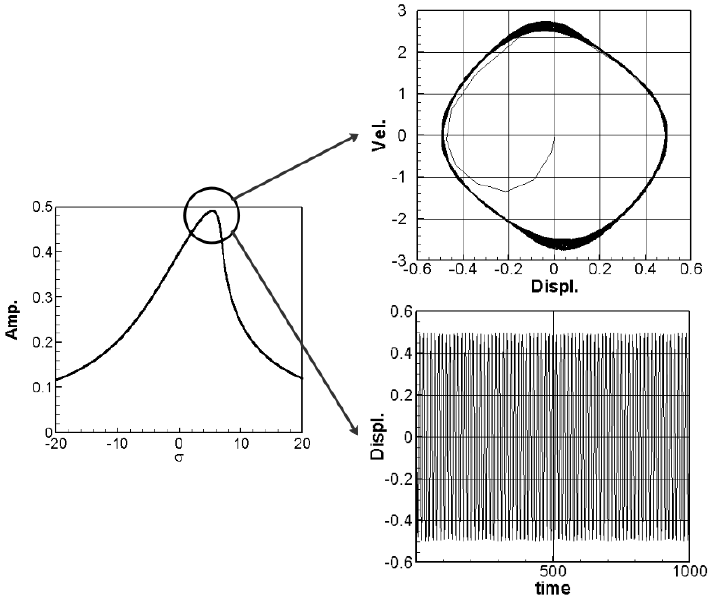
Figure 7. SES verification diagrams of fixed-point plots, phase plots, and time response plots of the 1st mode’s forced response.